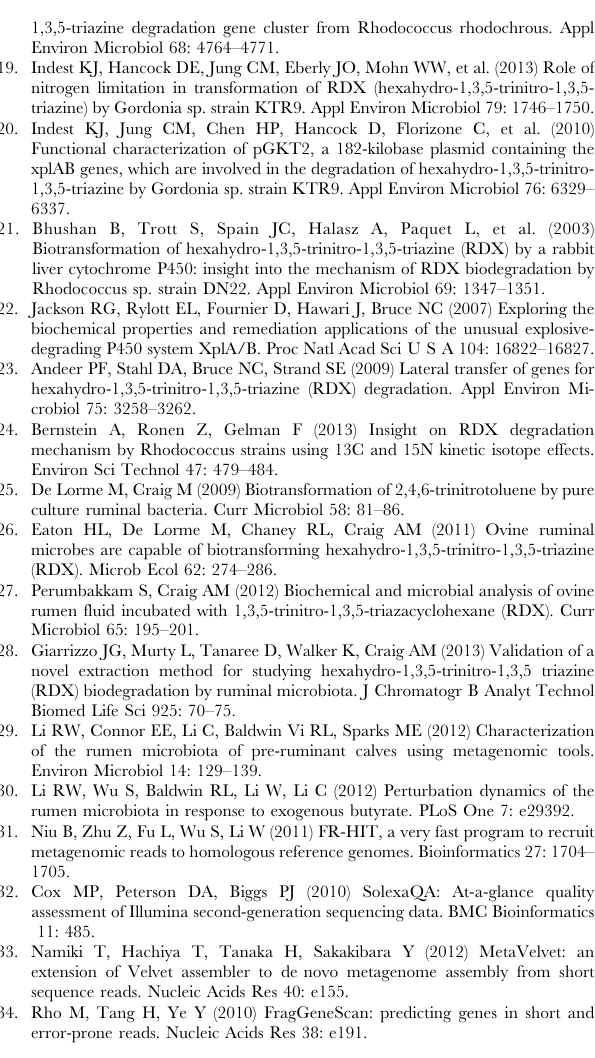
CD-HIT-OTU. The results in the table were obtained using the RDP Classifier. Table S4. The family-level microbial composition in the ovine rumen microbiome in response to RDX incuba- tion. The abundance data (raw counts) were derived from unassembled whole-genome shotgun sequences using the lowest common ancestor method in the MG-RAST